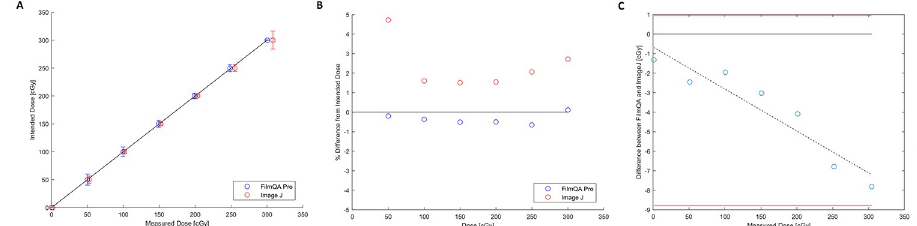
Fig 4. EBT3 for the 0–300 cGy dose range. A) Measured vs. intended dose. The solid line has a slope of one and is meant to guide the eye, as points falling on it indicate perfect agreement. Error bars represent 3 standard deviations. B) Percent difference from intended dose. C) Bland-Altman Plot.